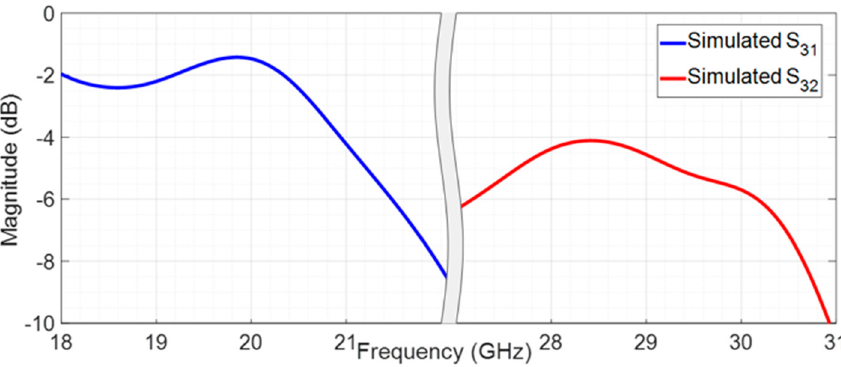
Figure 12. Simulated losses of the filtenna feeding structure.